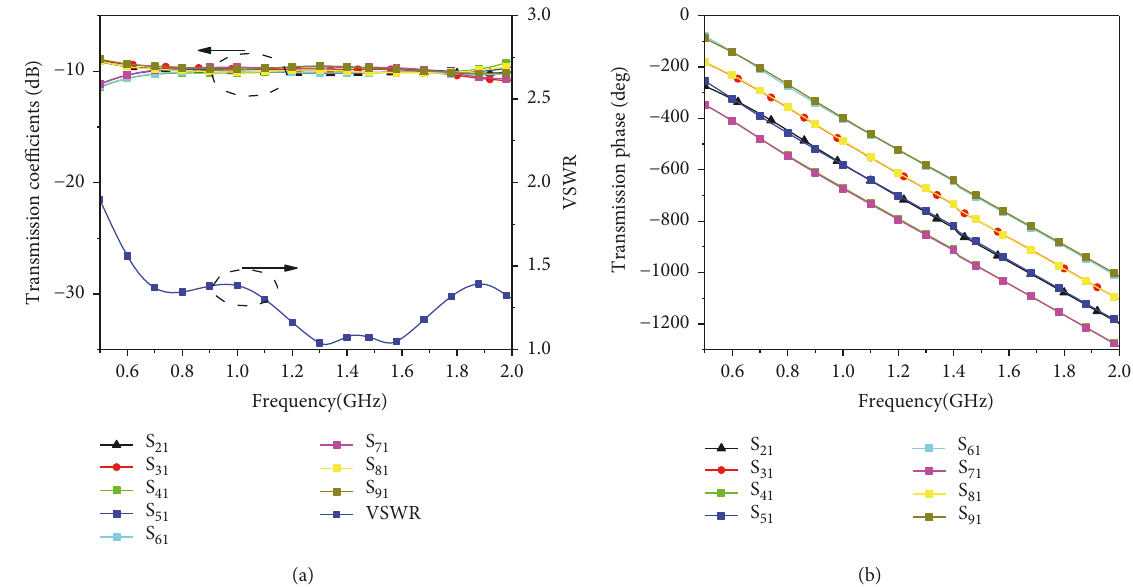
Figure 10: Performance of array feed network. (a) Transmission coe ffi cients and VSWR. (b) Transmission